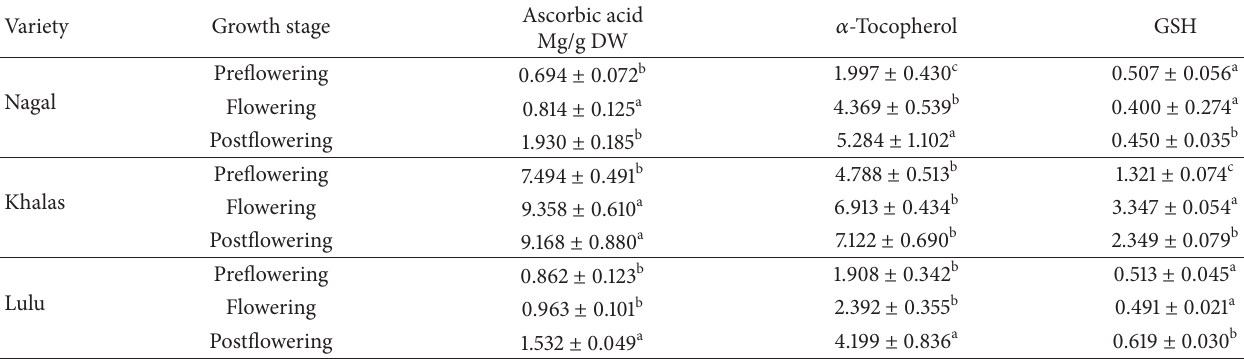
Ascorbic acid Mg/g DW